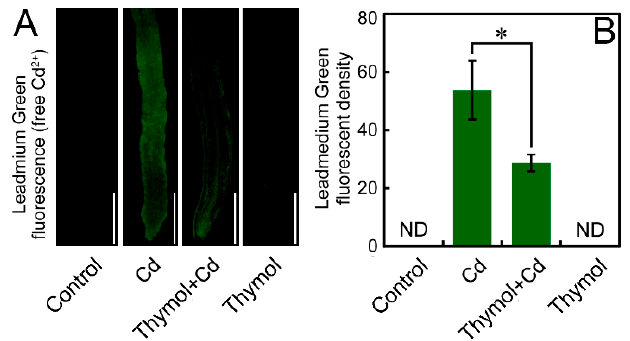
Figure 6. The effect of thymol on free Cd 2+ in the roots of tobacco seedlings under Cd stress. The roots of seedlings were treated with water (control), CdCl 2 (20 μ M), CdCl 2 (20 μ M) + thymol (100 μ M), and thymol (100 μ M) for 72 h. Then the roots were loaded with Leadmium TM Green AM for the observation of green fluorescence ( A ) and the quantification of fluorescent density ( B ). Bar = 1 mm. The asterisk in ( B ) indicates that the mean value of three replicates was significantly different between thymol + Cd treatment and Cd treatment alone ( p < 0.05).